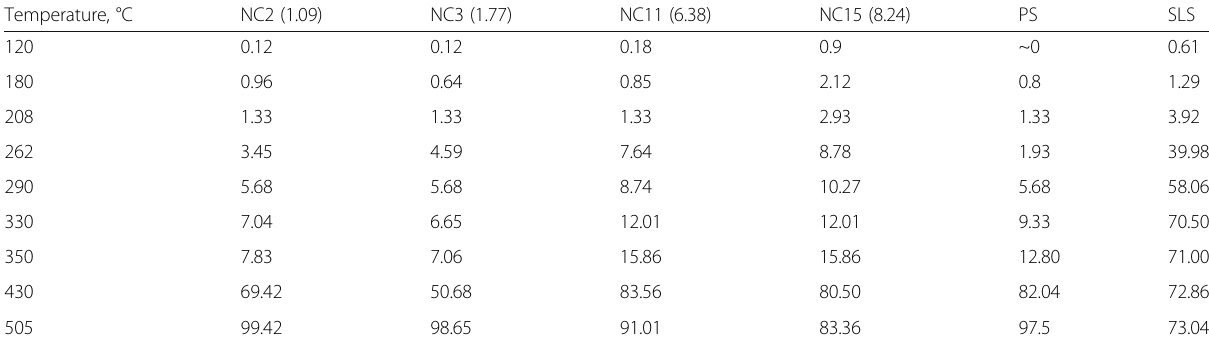
Table 2 Weight losses (in wt%) of the PS/PANI-LSA nanocomposites (see Table 1), control PS nanoparticles, and SLS samples at different temperatures. LSA contents are given in brackets Temperature, °C